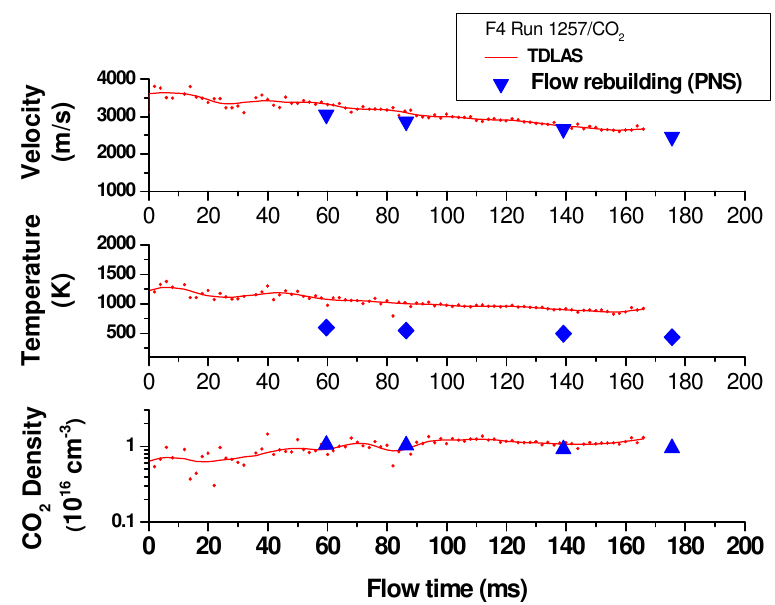
Figure 10. CO compiled results for F4 run 2